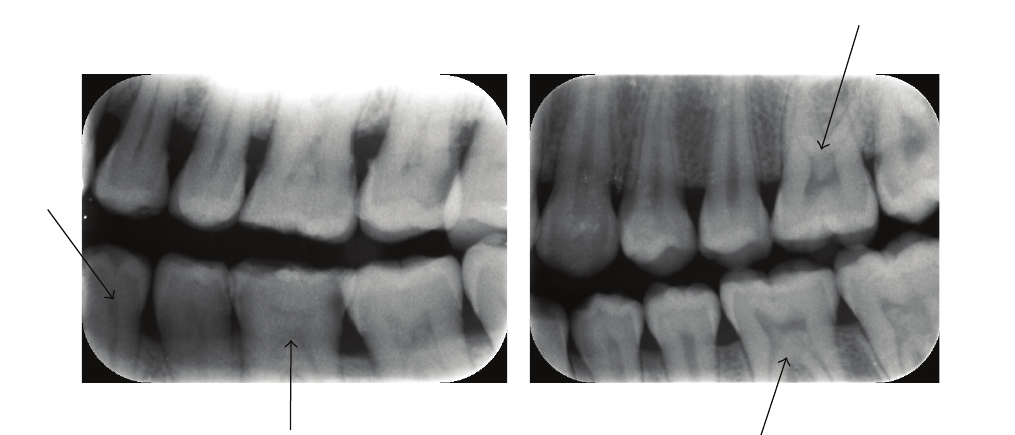
Figure 1: Pulp stone observed inside the pulp chambers of the molars and premolars in the bitewing radiograph.